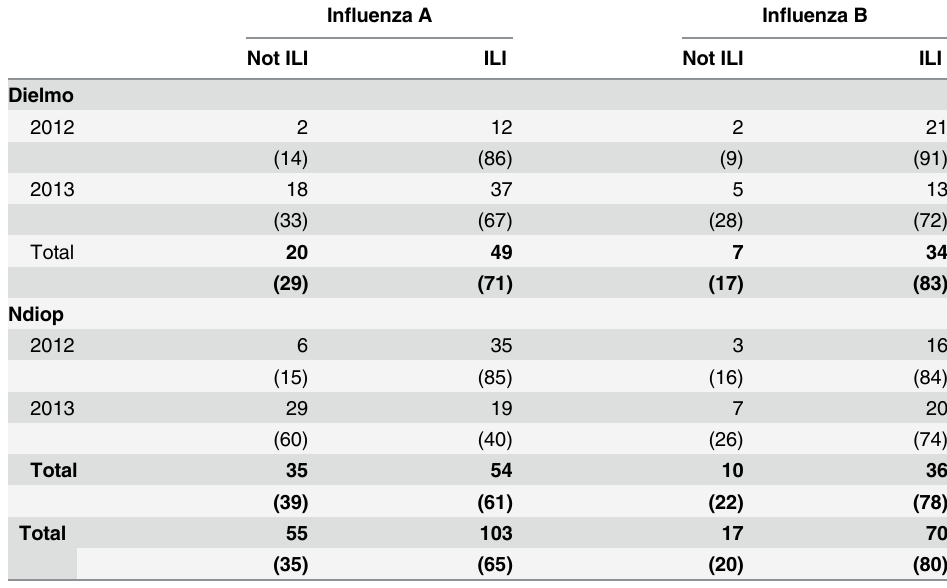
Table 4. Distribution of the virus according to ILI definition, village and year, in Dielmo and Ndiop, January 2012 – December 2013.